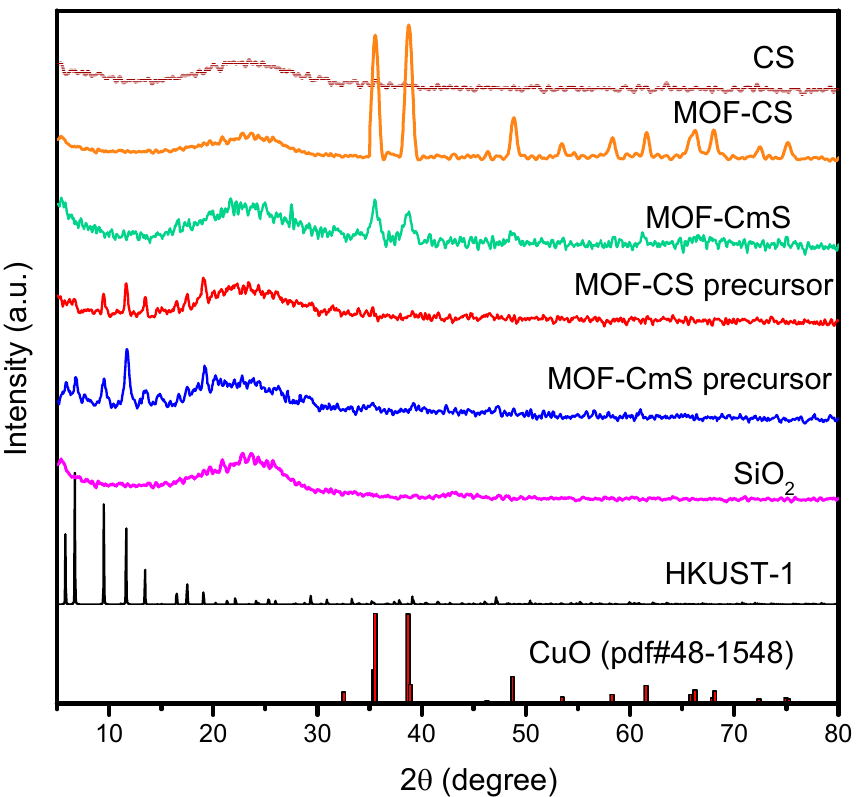
Figure 2. XRD patterns of pure HKUST ‐ 1, SiO 2 , and Cu/SiO 2 samples and their precursors . As shown in Figure 3, the FT ‐ IR spectra of HKUST ‐ 1, CS, MOF ‐ CS, MOF ‐ CmS, and their precursors were studied. The HKUST ‐ 1 shows a carboxyl absorption band at 1710 cm − l and symmetric and asymmetric stretching vibrations of carboxyl groups at 1645/1560 cm − 1 and 1445/1374 cm − 1 , respectively [26]. The bands at 1220 and 1100 cm − 1 are assigned to the stretching vibrations of Si–O bonds; the bands at 958 cm − 1 correspond to the existence of non ‐ bonded oxygen Si–OH bonds [27]. The bands at 802 and 471 cm − 1 are attributed to the bending vibrations of Si–O bonds and –O–Si–O– bonds, respectively [28]. The infrared characteristic peaks of the HKUST ‐ 1 can be observed on the MOF ‐ CmS and MOF ‐ CS precursors. It is worth noting that the MOF ‐ CmS shows a sharper charac ‐ teristic FT ‐ IR peak of HKUST ‐ 1 than MOF ‐ CS, which can be ascribed to the large number of carboxylic acid sites provided by the modified silica microspheres. The absorption linkers have been completely removed. There are mainly two kinds of Cu species left on